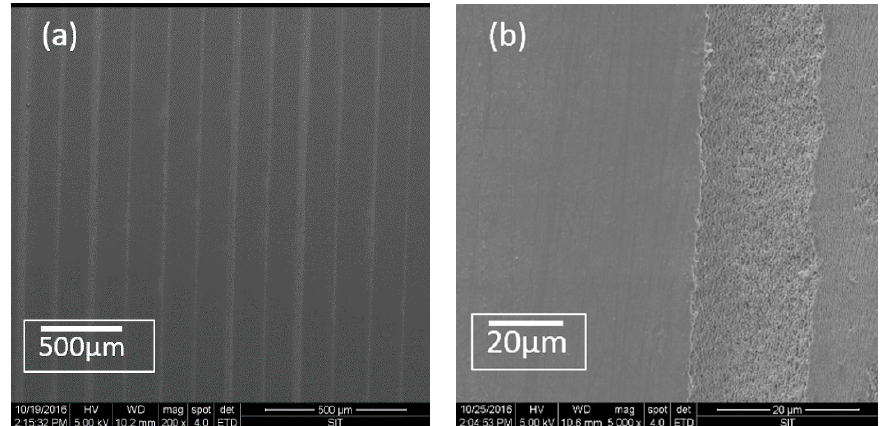
Figure 2. SEM (scanning electron microscopy) images of surface microstructure of the striped U-shaped groove. ( a ) magnification is 200×; ( b ) magnification is 5000×.